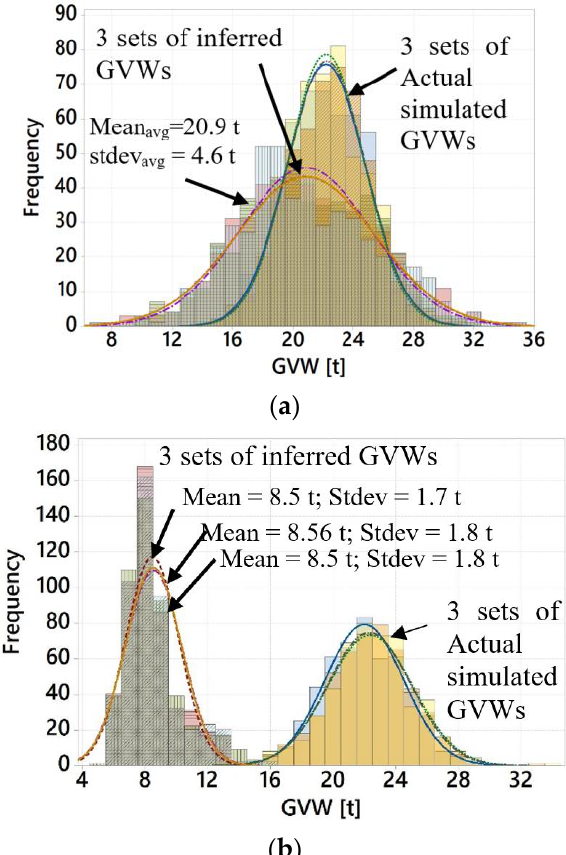
Figure 6. Histograms of actual simulated GVWs and inferred GVWs for the case of a healthy bridge with 500 half-car vehicles using: ( a ) smooth profile; ( b ) class ‘A’ road profile.